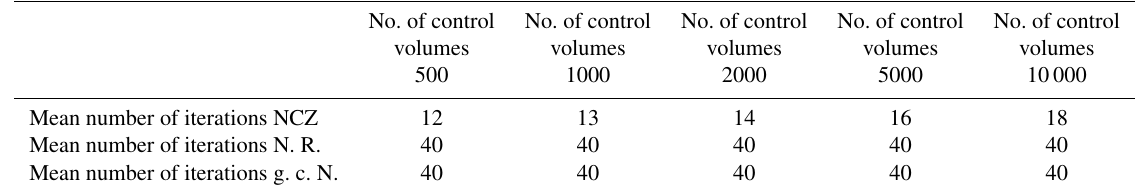
Mean number of iterations N. R. Mean number of iterations g. c.